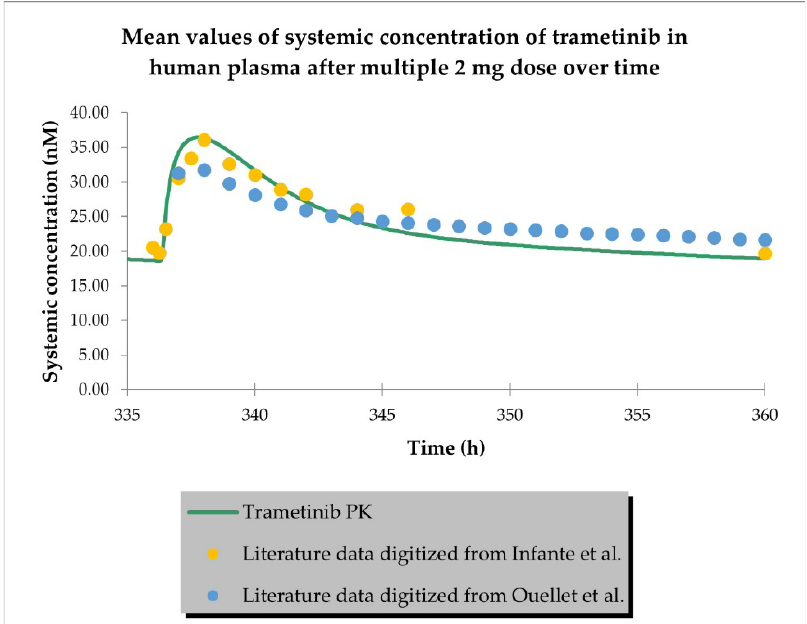
Figure 2. PBPK model of trametinib after a single dose in cancer patient representative. Observed data are presented as means from literature data (digitised from Ho et al. [30] and Ouellet et al. [31] * Geometric mean from digitised data. ** Geometric mean from digitised data from typical male and female with as indicated in Table 3). a median body weight of 79 kg.